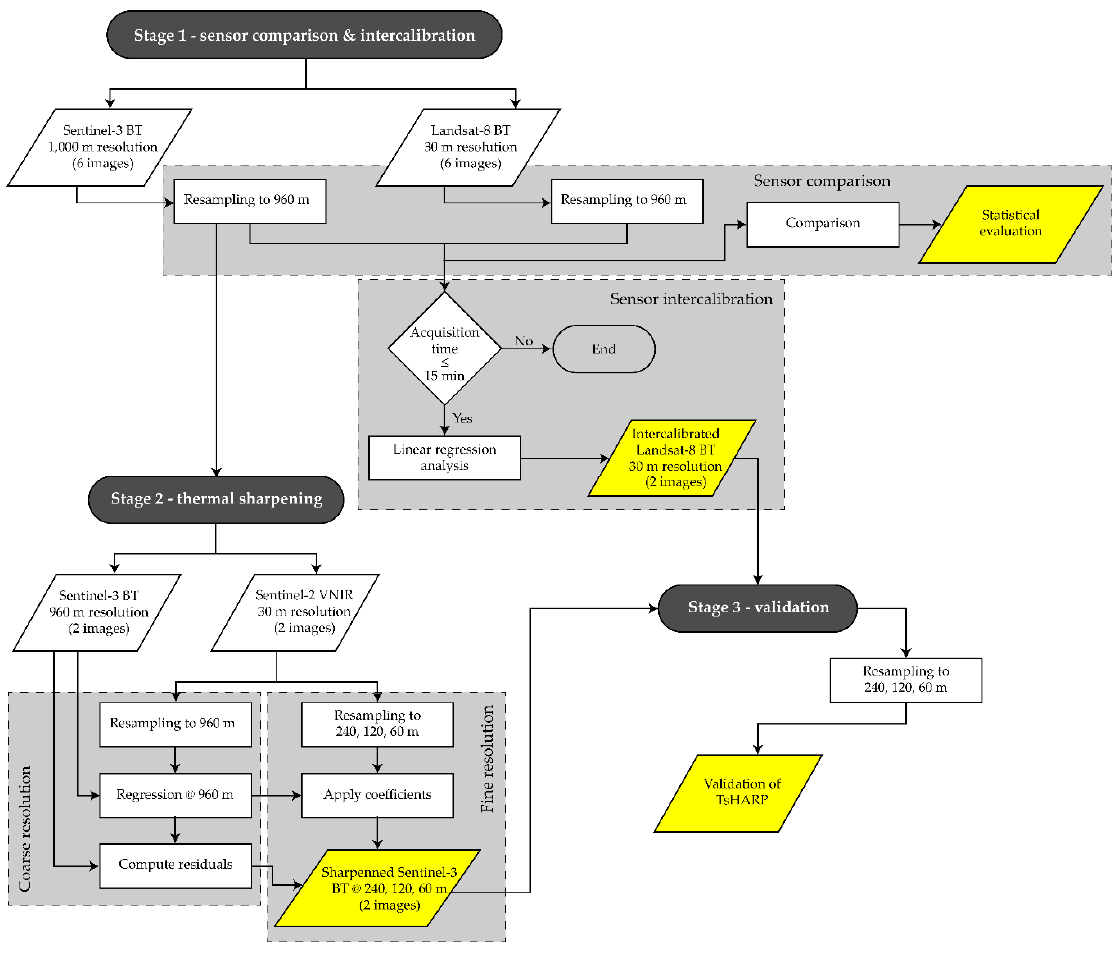
Figure 1. Data processing flow chart. Table 1. List of study sites and Landsat 8, Sentinel-3, and Sentinel-2 images used in this